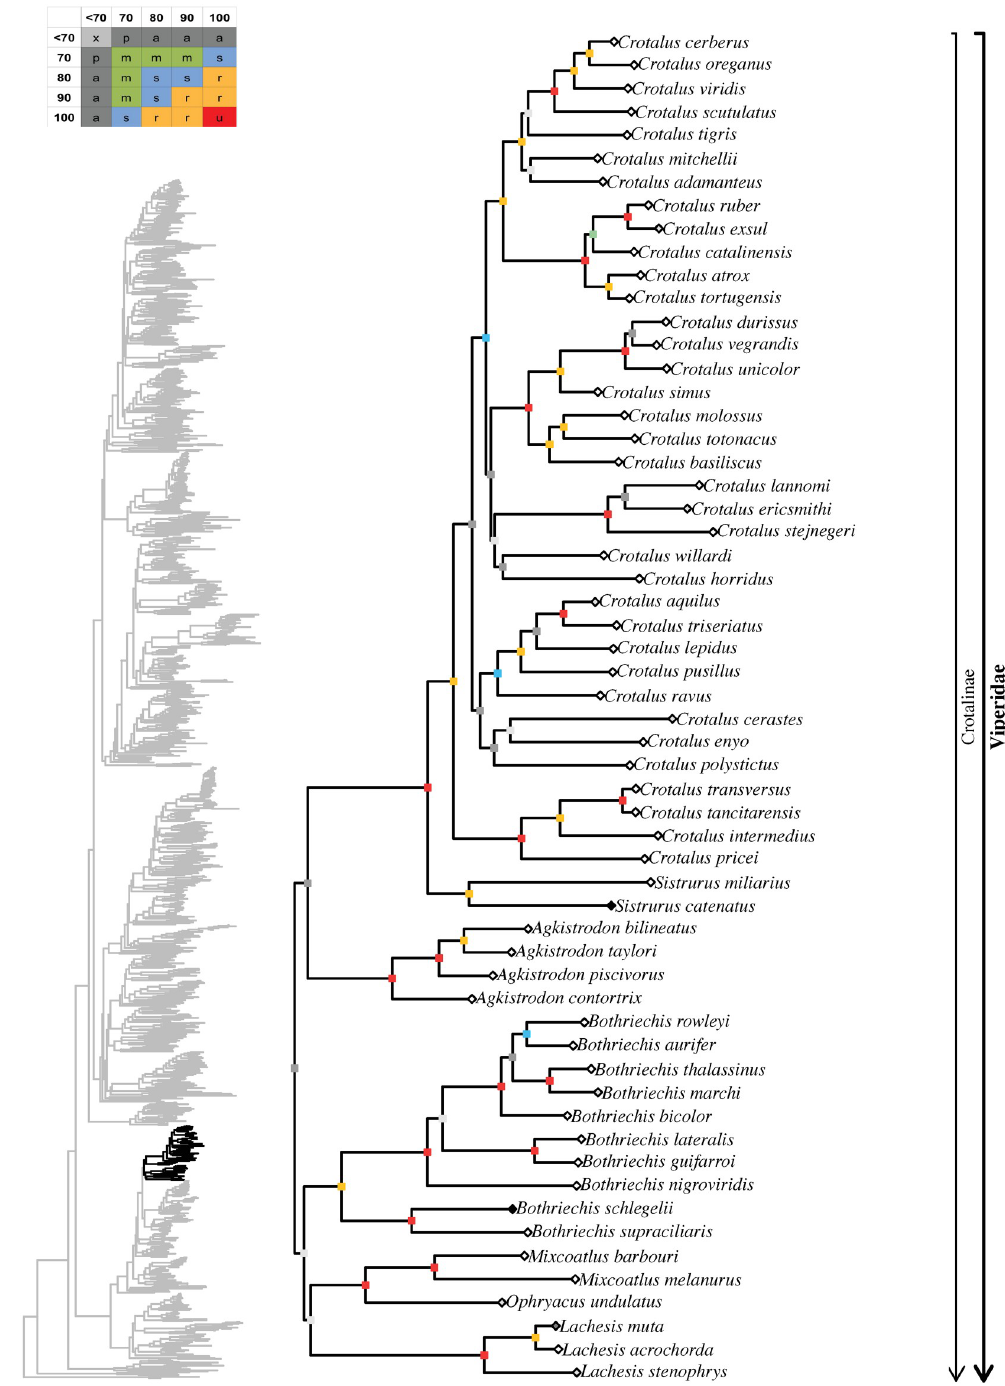
Fig 9. Maximum likelihood species-level phylogeny of Colubroides (continued). Family Viperidae, subfamily